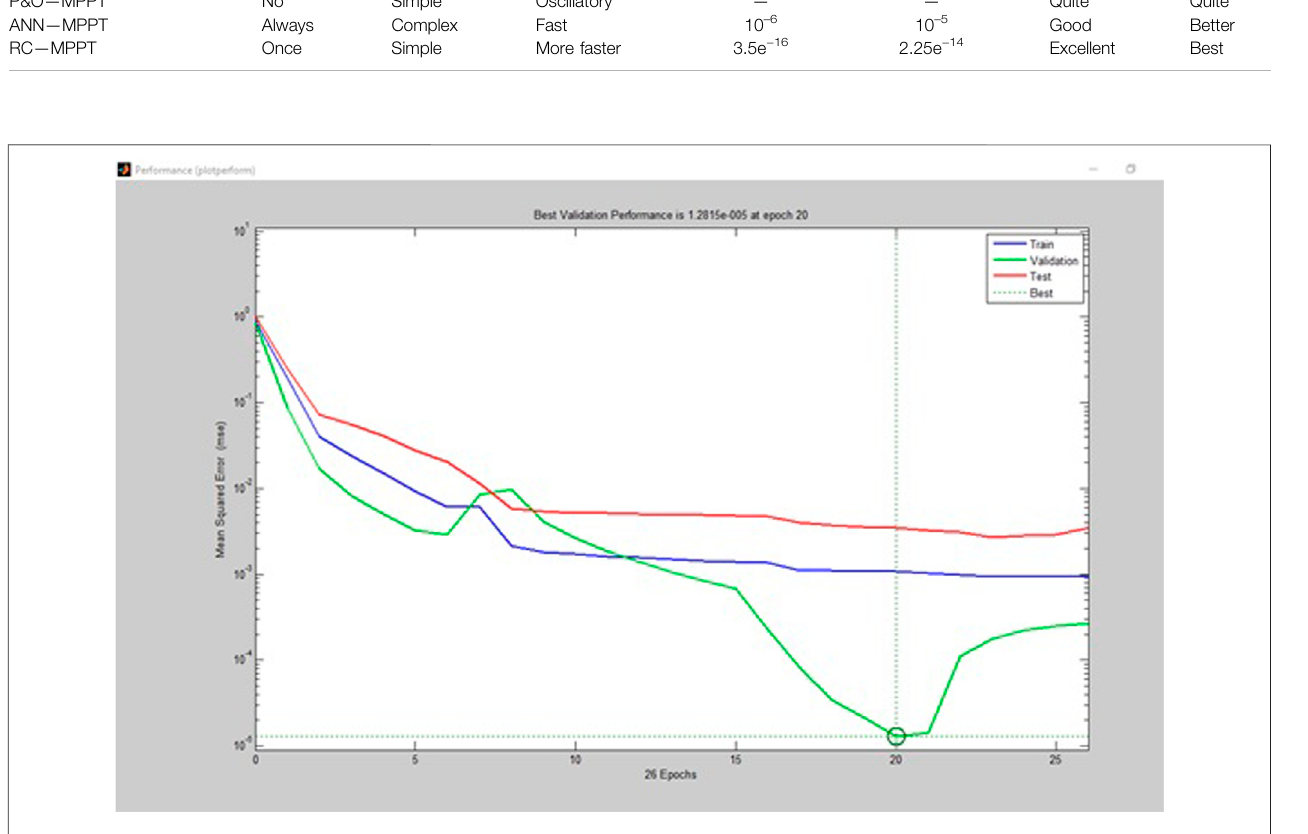
Frontiers in Energy Research |